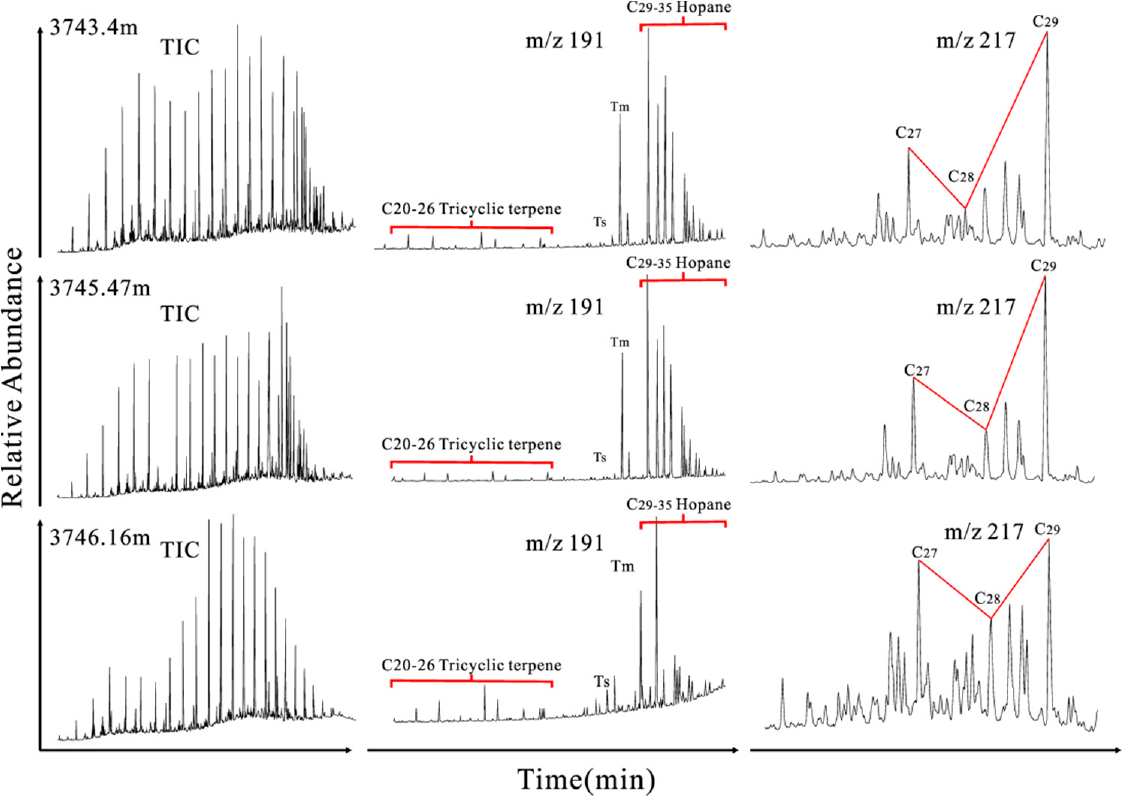
Figure 4. Atlas characteristics of the samples of Qingshuiying Formation by pyrolysis.